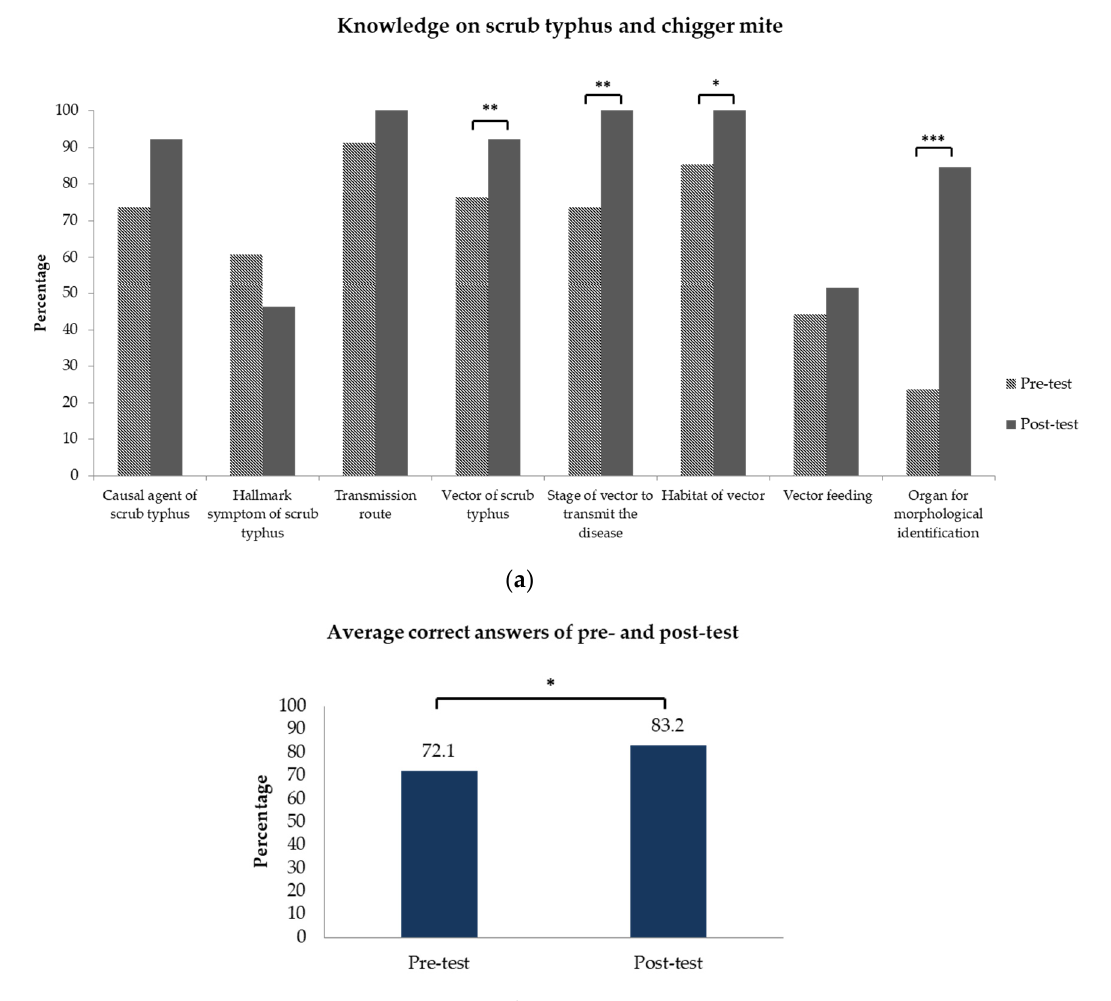
Figure 1. Knowledge improvement after the distance learning method: ( a ) the proportion of correct answers increased significantly on most questions; ( b ) the overall average of correct answers increased significantly after the distance learning method. * significant at p < 0.05; ** significant at p < 0.01; *** significant at p < 0.001.